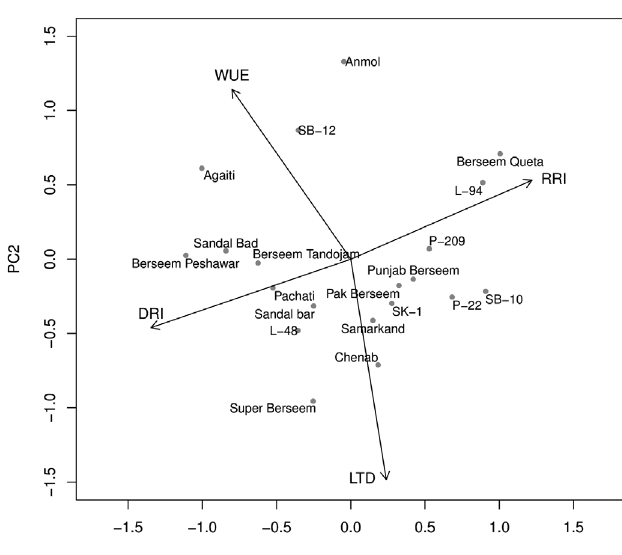
Fig. 3: GGE biplot for standardized leaf temperature depression (LTD), drought resistance index (DRI), recovery rate index (RRI) and water use efficiency (WUE) for twenty ecotypes of berseem clover ( Trifolium alexandrinum L.) under water restriction. LTD, DRI, RRI, and WUE were averaged across replications for each combination of Genotype-by-Trait. The first principal component axis (PC1) retains 41% and the second 31% of sum of